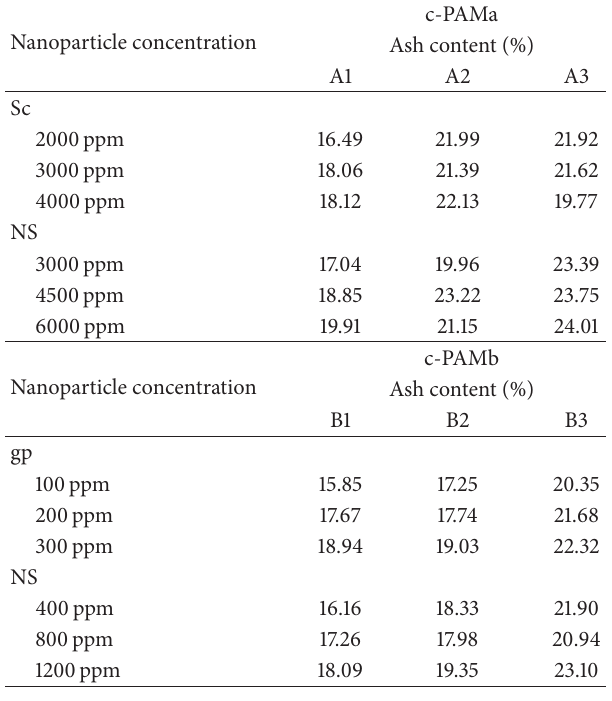
Table 3: Effects of substituting Sc and gp with NS on the ash content of